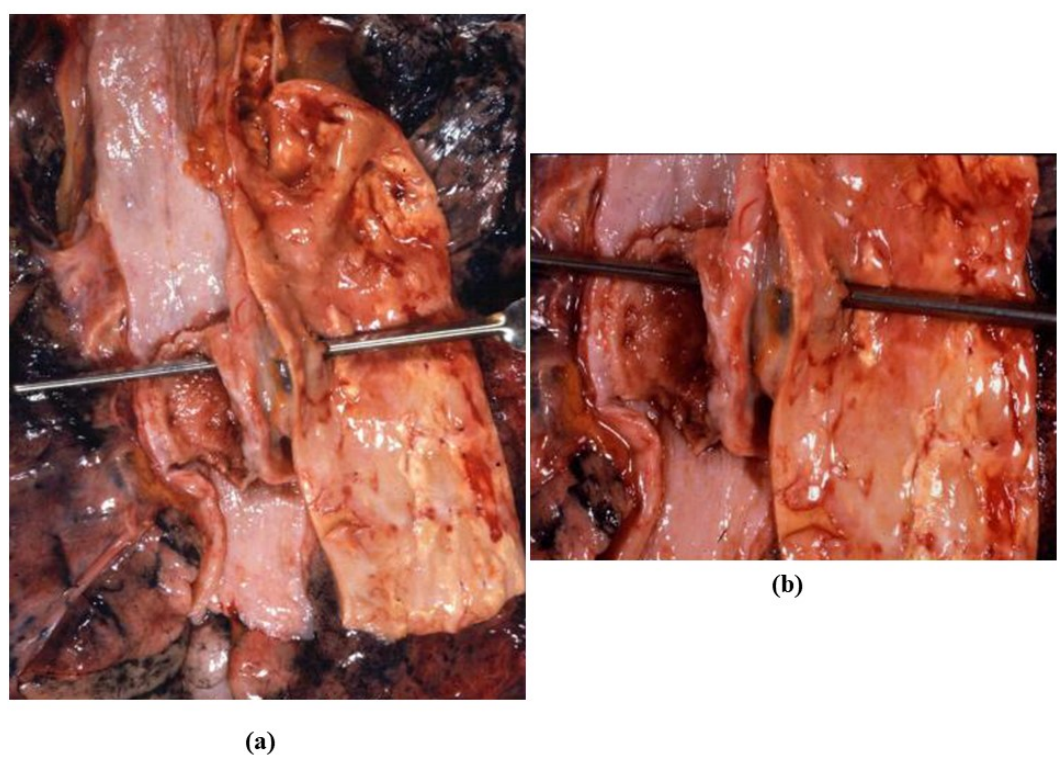
Figure 29. Carcinoma of the esophagus, infiltrating the adjacent aorta and penetrating in the aortic lumen, with massive hematemesis ( a ) Gross view. ( b ) Close up.